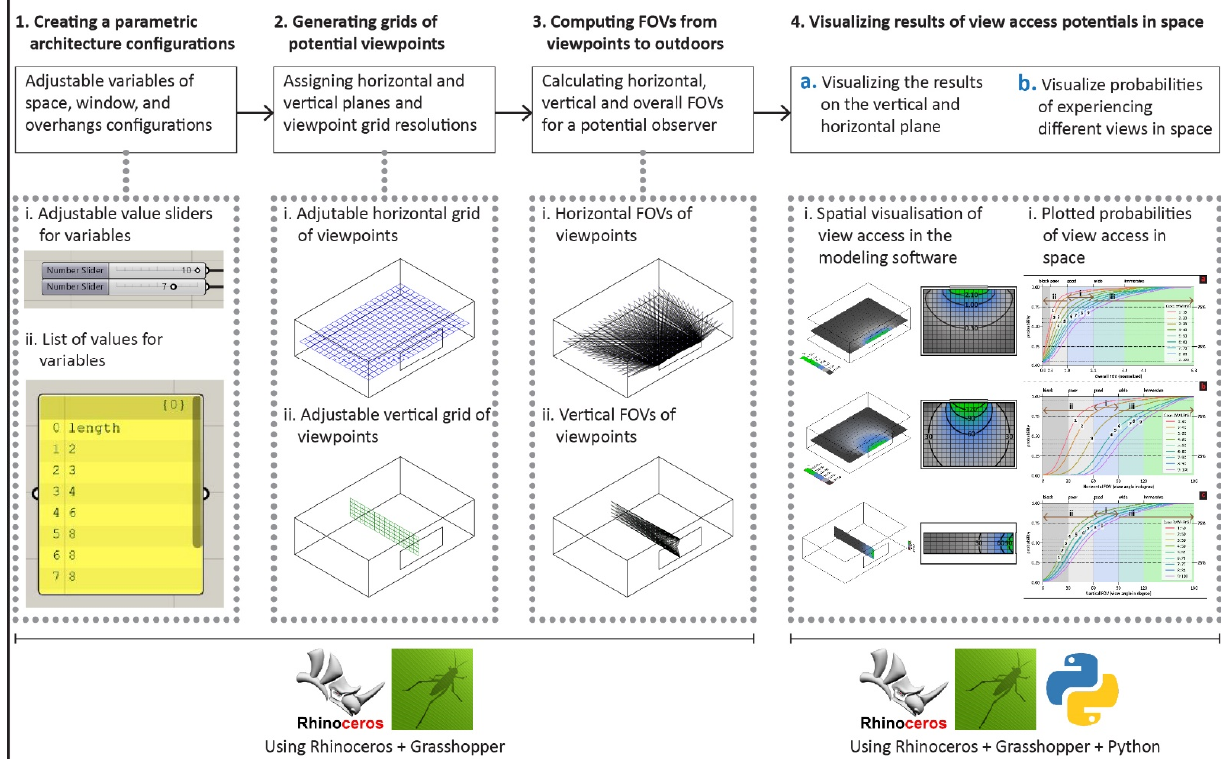
Figure 4. The developed parametric workflow to compute and visualize the view access in space.